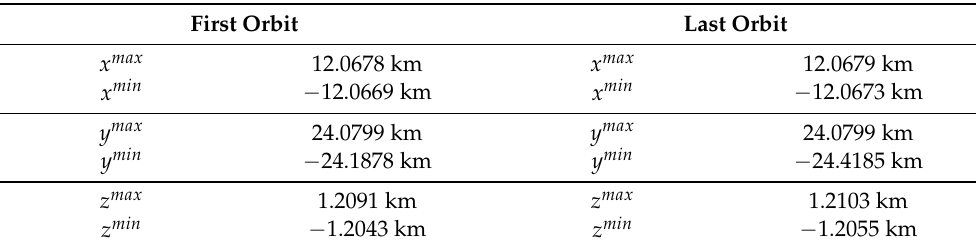
Figure 11. Lunar formation: J n -invariant bounded trajectory (black) in F r ; the first orbit is plotted in red. Table 12. Lunar formation: maximum and minimum value of the position coordinates for the first and the last